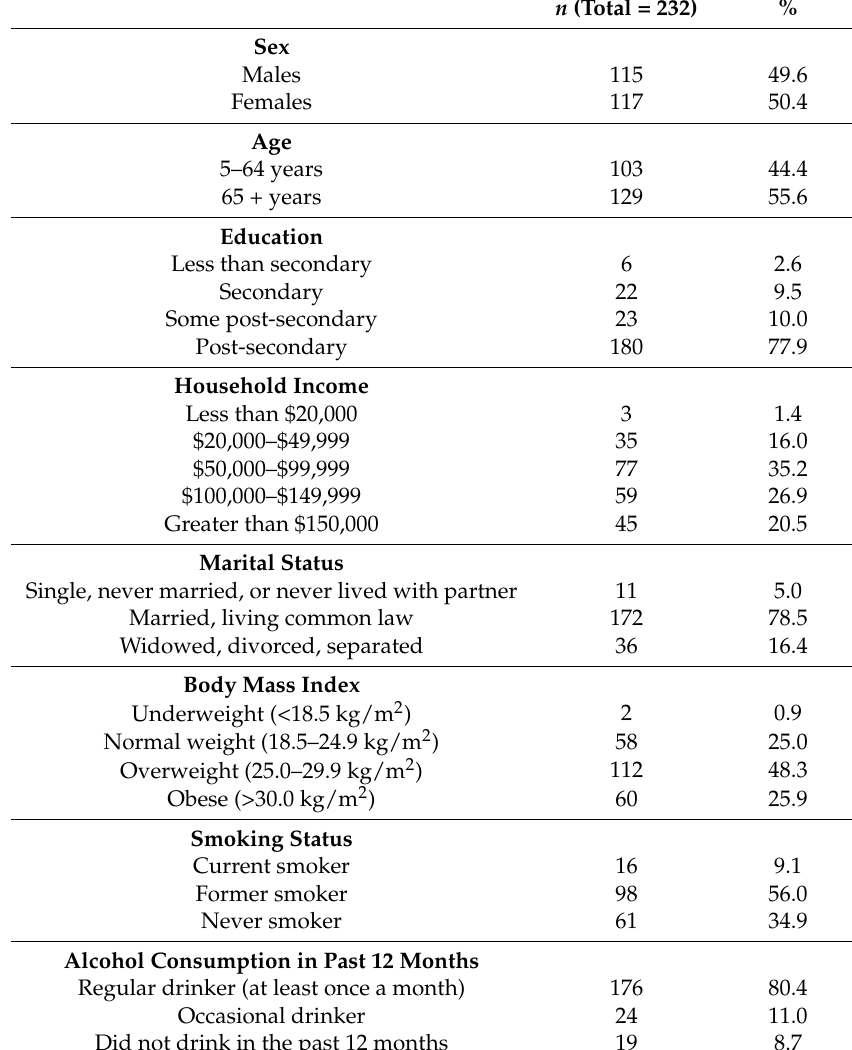
Table 1. Socio-demographic characteristics of the Canadian Longitudinal Study on Aging (CLSA) Diet Study